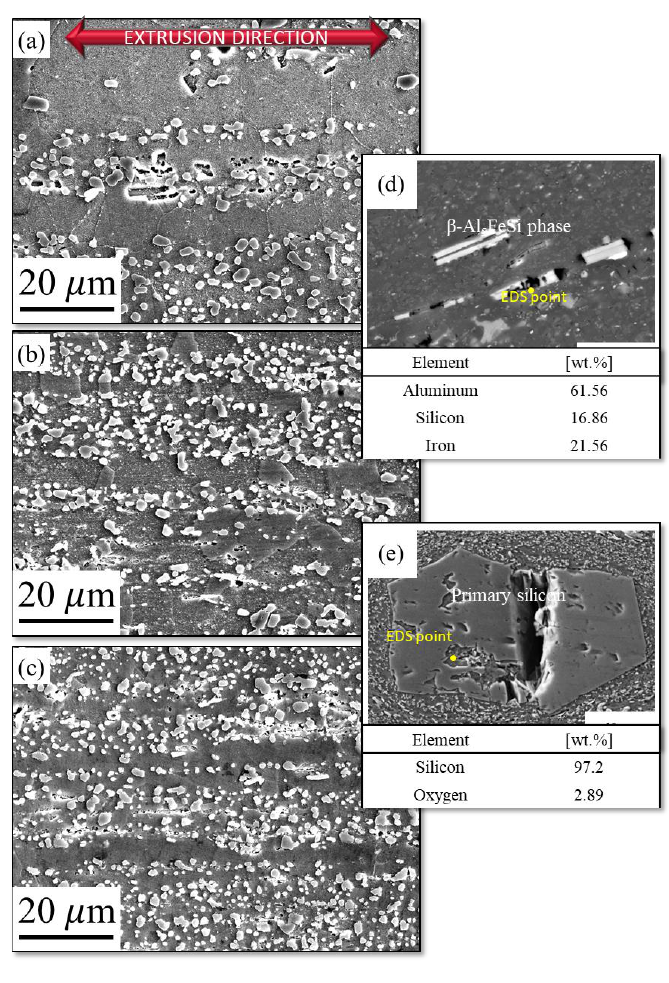
Figure 2. SEM Micrographs of Al-XSi-3Cu-0.6Mg-0.5Fe [X = ( a ): 10; ( b ): 12.6; ( c ): 14] extruded alloys;